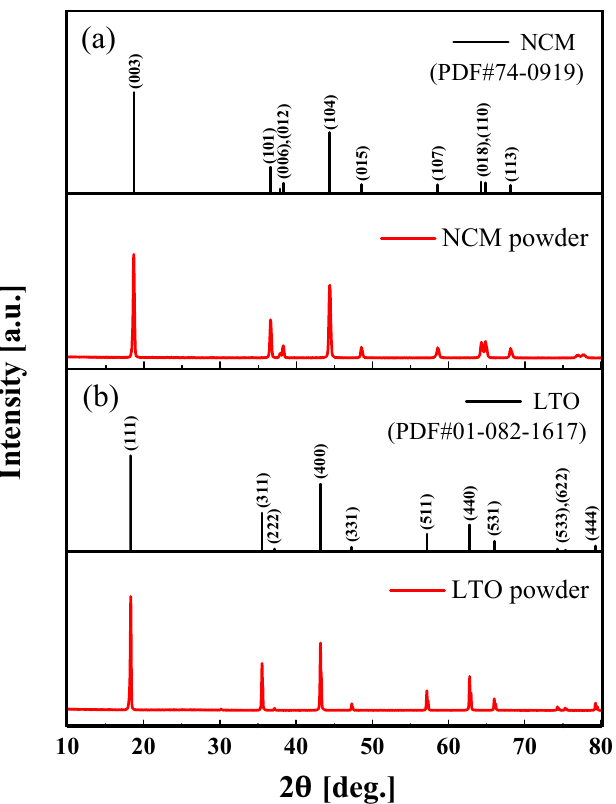
Figure 2. XRD patterns of ( a ) NCM (PDF#74-0919) powder and ( b ) LTO (PDF#01-082-1617) pow- der.